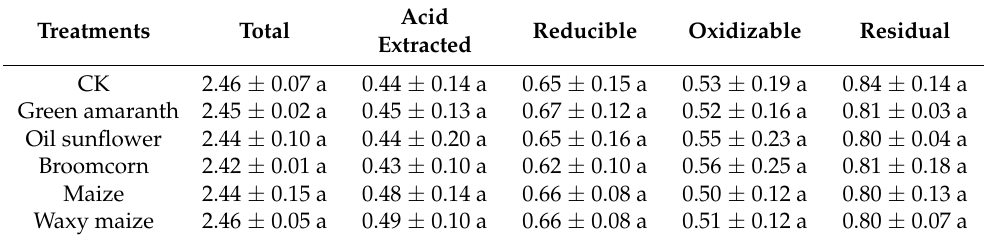
Table 2. The speciation of Cd in soil after restoration by different plants (mg · kg − 1 ).